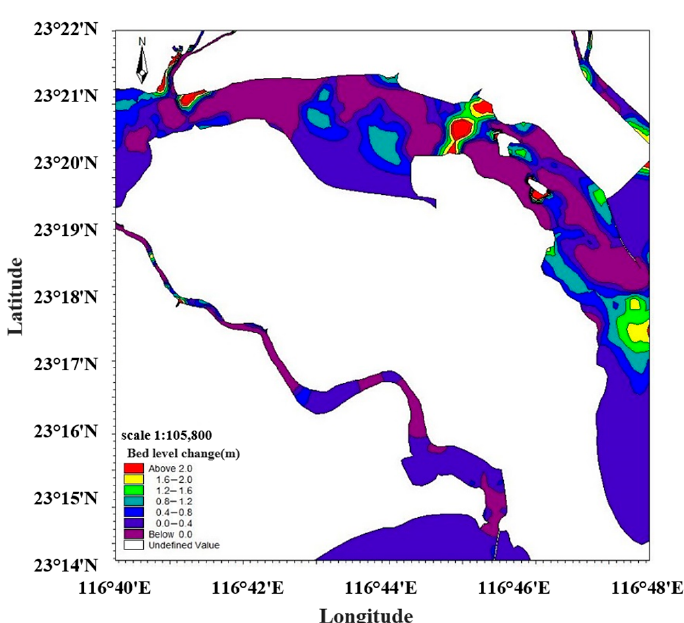
Figure 2. Changes of the bed bottom in the Shantou Port in five years.